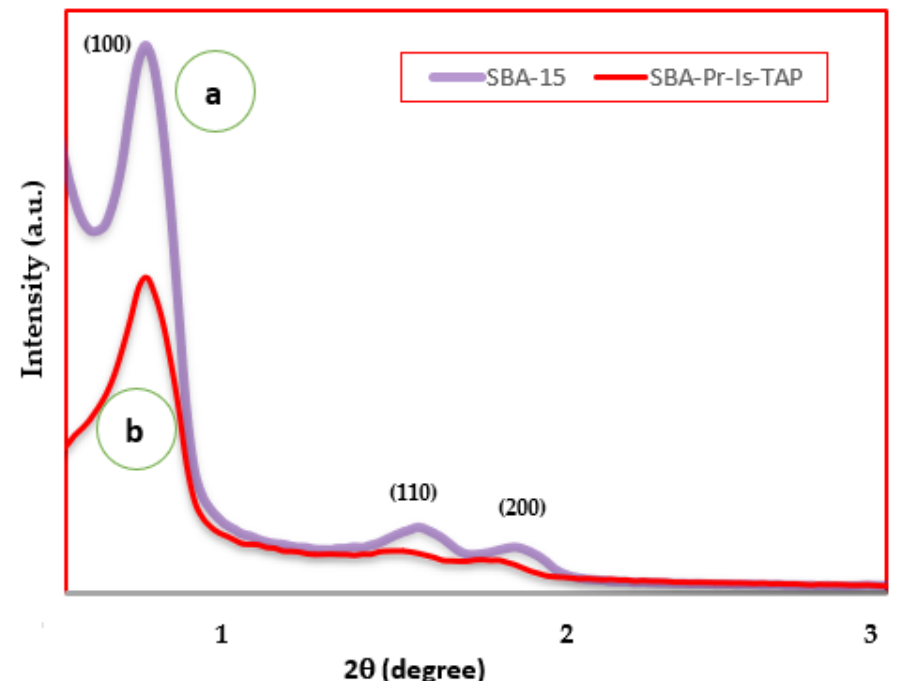
Figure 2. Low-angle XRD profiles of ( a ) SBA-15 and ( b ) SBA-Pr-Is-TAP.